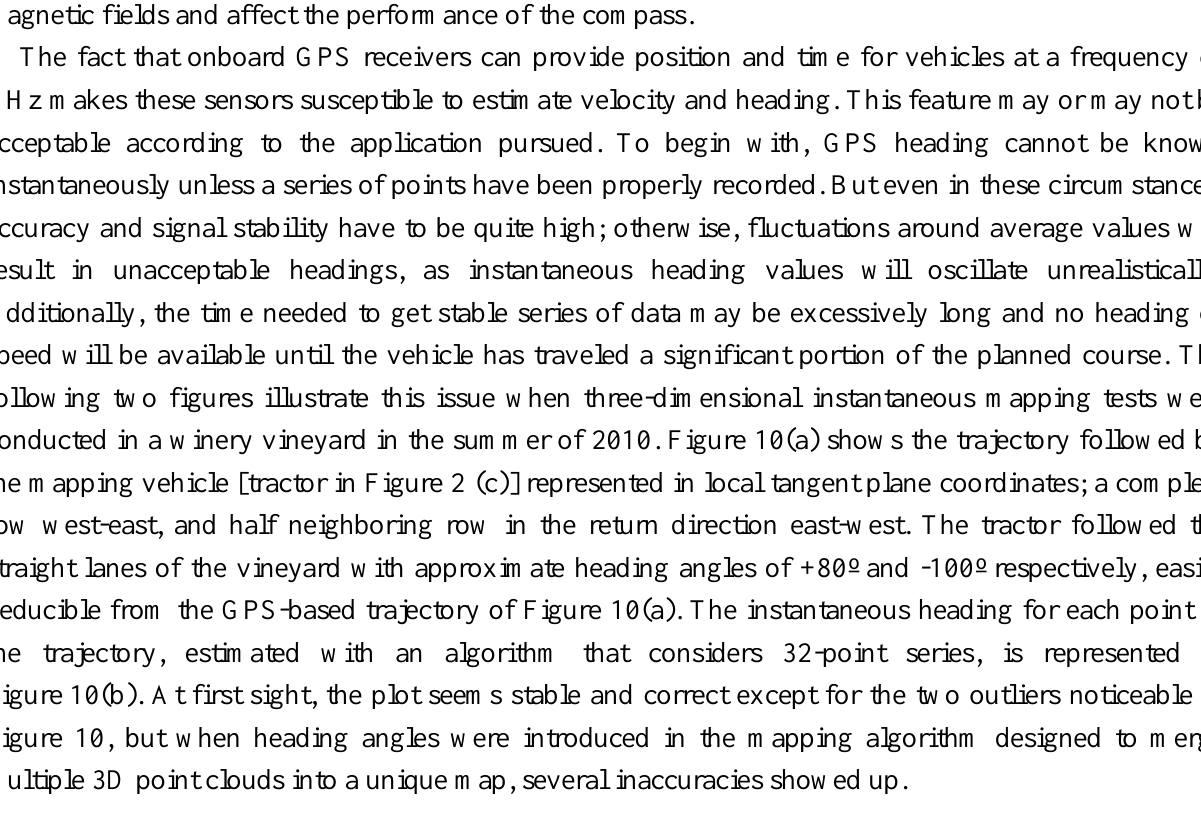
Figure 10. GPS-based heading estimation: (a) Vehicle trajectory. (b) Instant